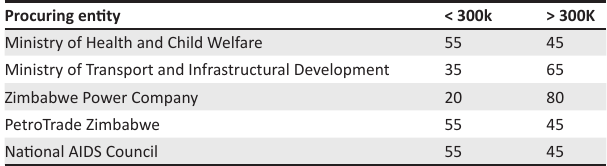
TABLE 5: Average percentage of purchases.